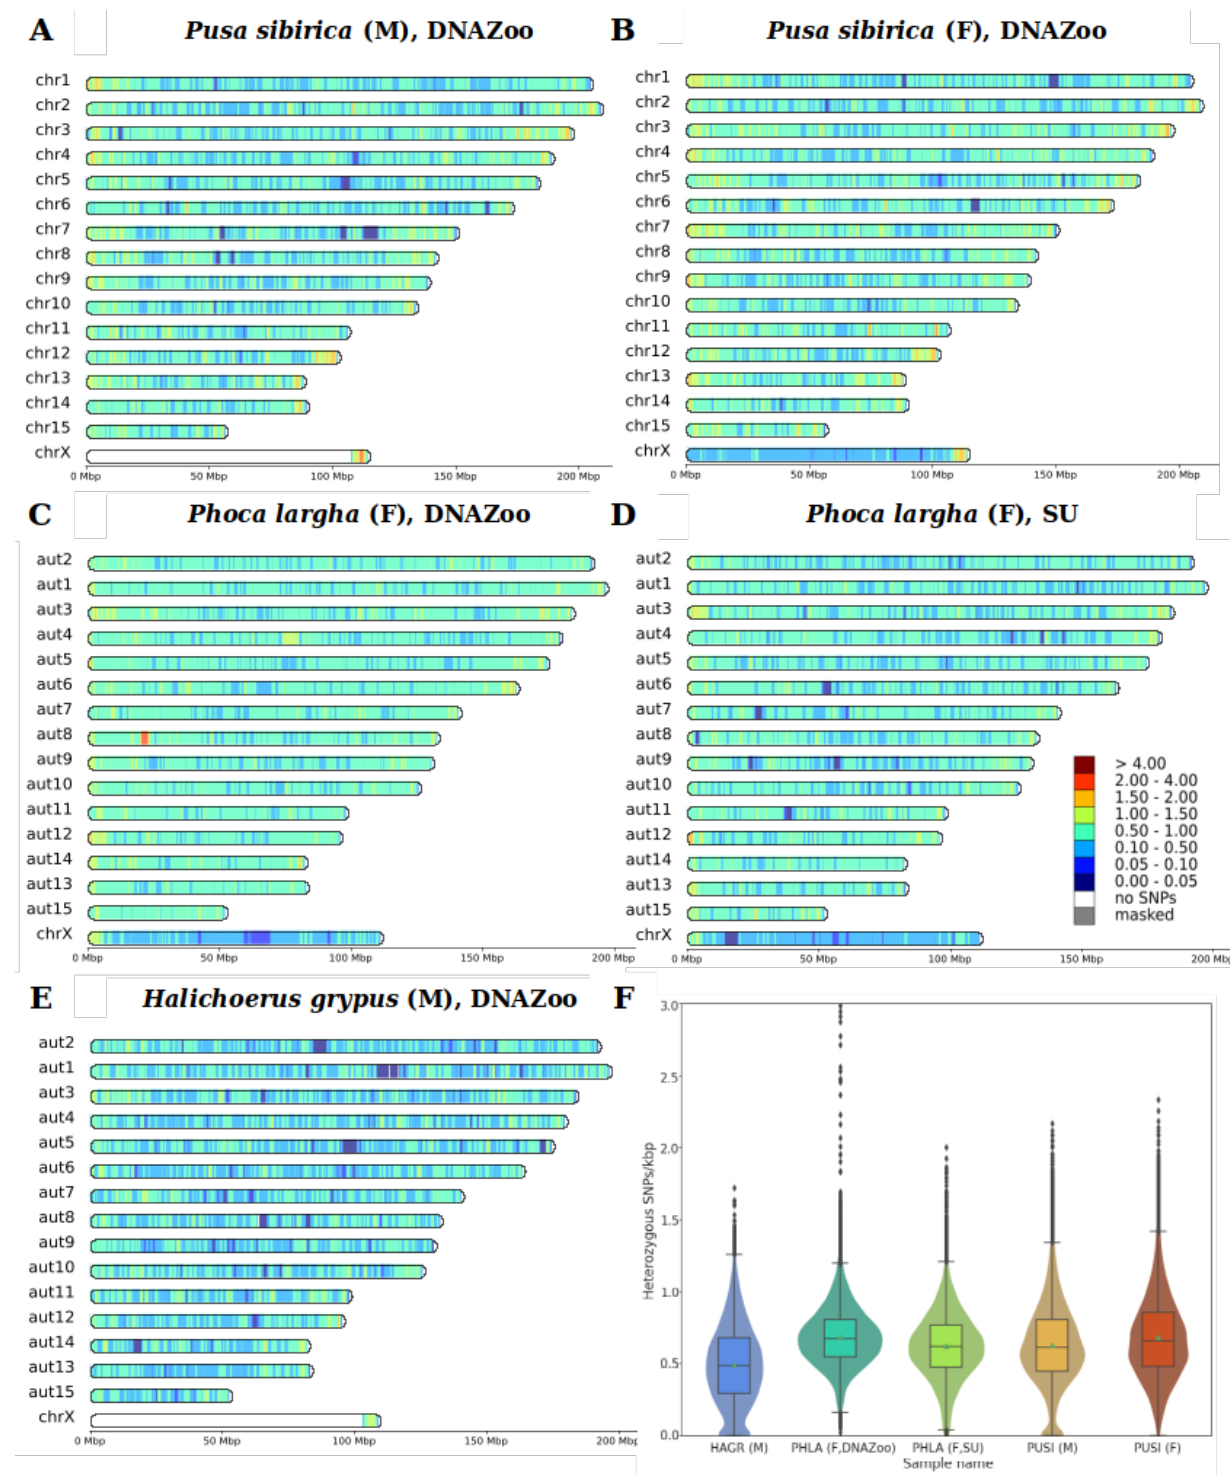
Figure 3. Heterozygous SNP densities (SNPs/kbp) for analyzed samples of three pinniped species. HetSNPs were counted in 1 Mbp sliding windows, with a 100 kbp step size, and scaled to SNPs/kbp. ( A ) PSIB, male, ( B ) PSIB, female, ( C ) HGRY, male, DNA Zoo, ( D ) PLAR, female, DNA Zoo, ( E ) PLAR, female, Seoul University, ( F ) violin and boxplots of heterozygosity distribution for all five pinniped samples. Autosomes of PLAR and HGRY were arranged according to their correspondence to PSIB and PVIT